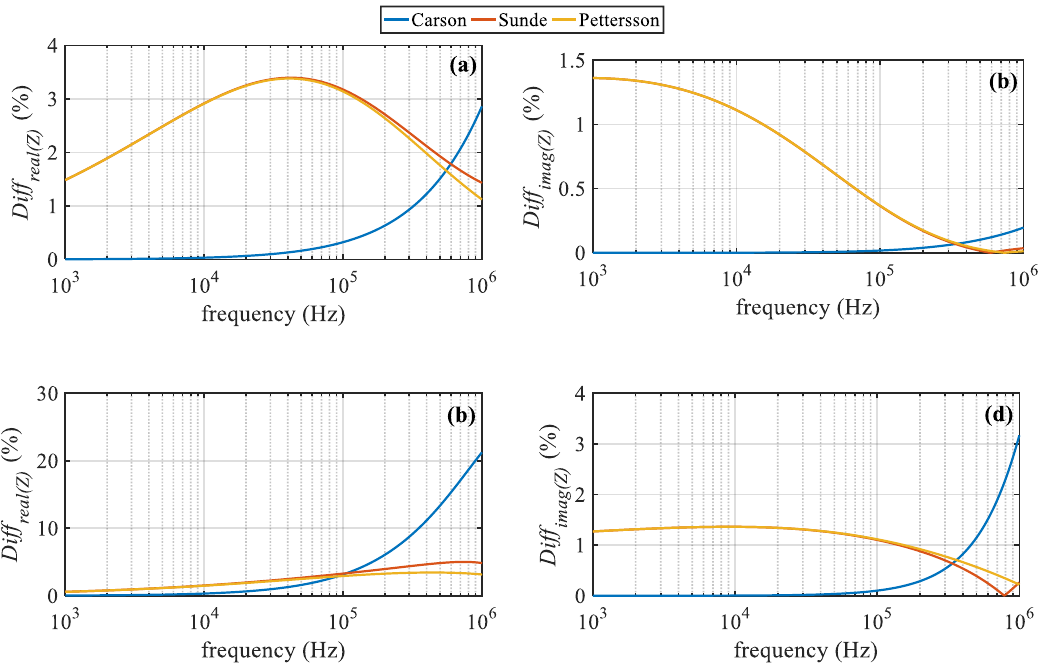
Figure 17. Di ff erences in Z 13 in NB. For ρ g = 100 Ω m, ε rg = 10, ( a ) real part, ( b ) imaginary part, for ρ g = 1000 Ω m, ε rg = 10, ( c ) real part and ( d ) imaginary Figure 17. Differences in Z 13 in NB. F or ρ g = 100 Ωm, ε rg = 10, ( a ) real part, ( b ) imaginary part, for ρ g = 1000 Ωm, ε rg = 10, ( c ) real part and ( d ) imaginary part.